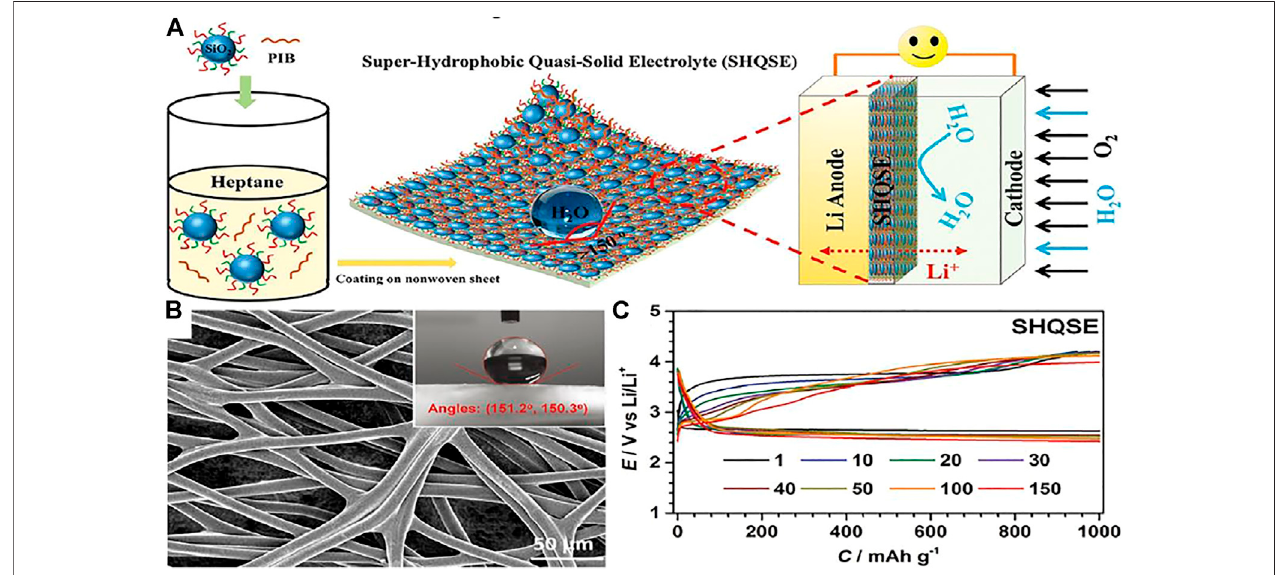
FIGURE10|(A) Schematicdiagram ofsolidLi-O 2 batteryinhumidatmosphereonbasisofthesuperhydrophobicquasi-solidelectrolyte(SHQSE). (B) SEMimage oftheoriginalnonwovenfabricand theinsets arethecorresponding waterCA. (C) Thetypical discharge – chargepro fi lesofLi-O 2 batterieswhenrelative humidityis45% (Wu et al., 2017b).